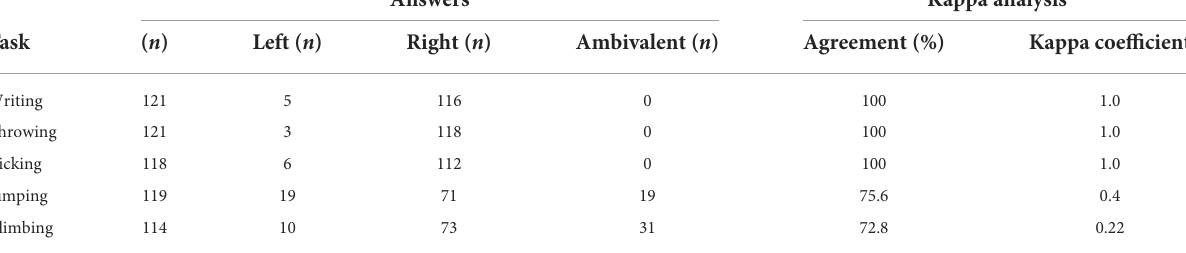
TABLE 1 Kappa coefficient, which is the quantity of agreement, adjusted for chance, and percentage of agreement between the first and second test